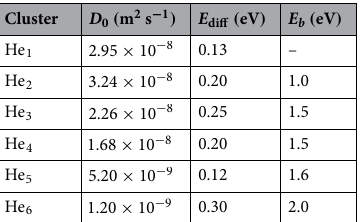
Table 1. Pure He clusters properties in W. Diffusion properties are taken from Faney et al. 30 and binding energies are taken from Becquart et al. 36 .